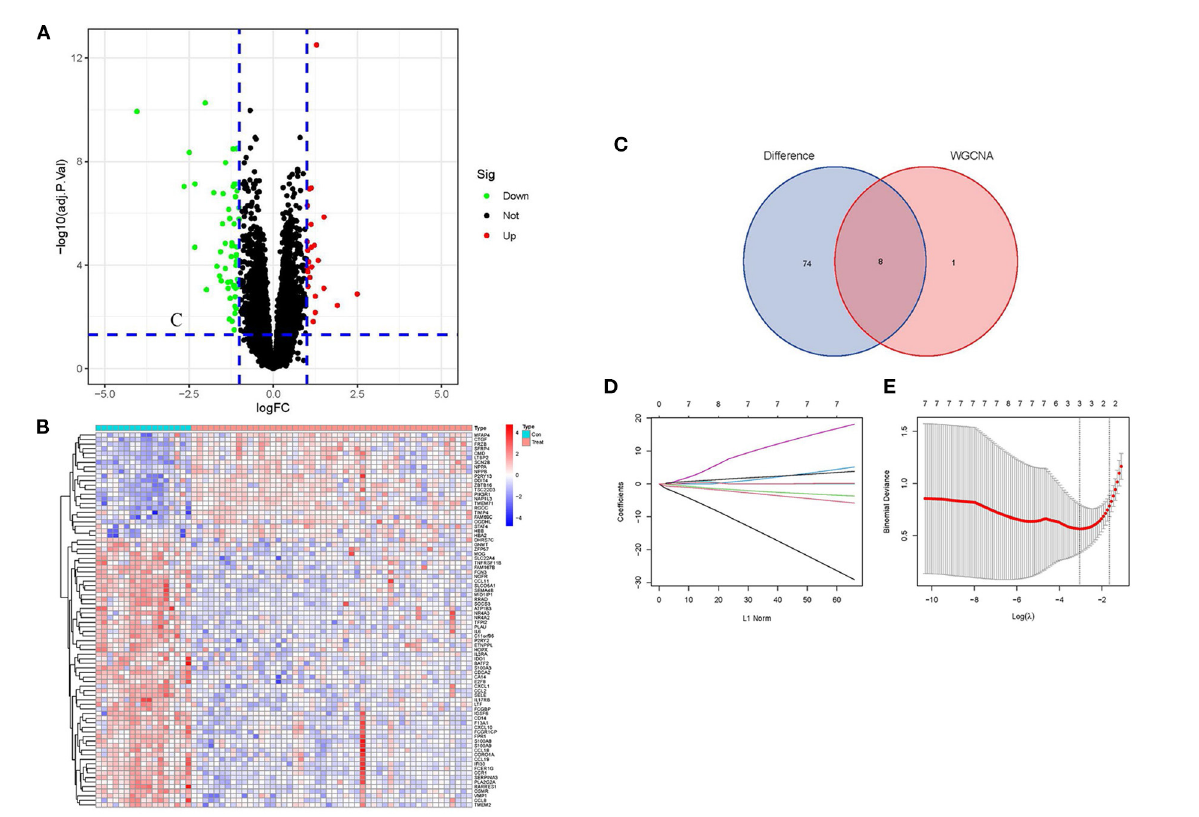
FIGURE3 Screening of DEGs and identification of Hub genes. (A) Volcano plots of DEGs expression in control and cardiomyopathy groups. (B) Heatmap of DEGs expression in cardiomyopathy and control groups. (C) Venn diagram of the DEGs’ intersection and candidate genes of the turquoise module. (D) Map of the regression coefficients of the eight genes in LASSO model. (E) Three hub genes screened by 10-fold cross-validation in the LASSO regression model.